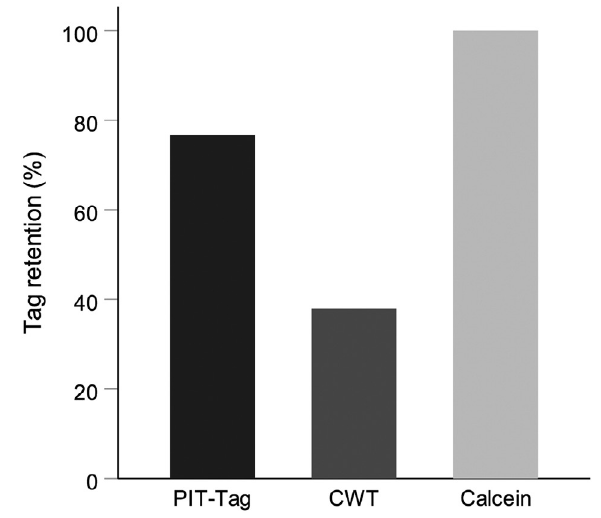
Fig. 2. – Retention (%) of PIT-tags, coded wire tags (CWTs) and calcein used to tag Paracentrotus lividus after a 60-day experimental period in the laboratory (n=30 individuals per treatment, except the CWT group, n=29). A significant association between tagging method and tag retention was detected